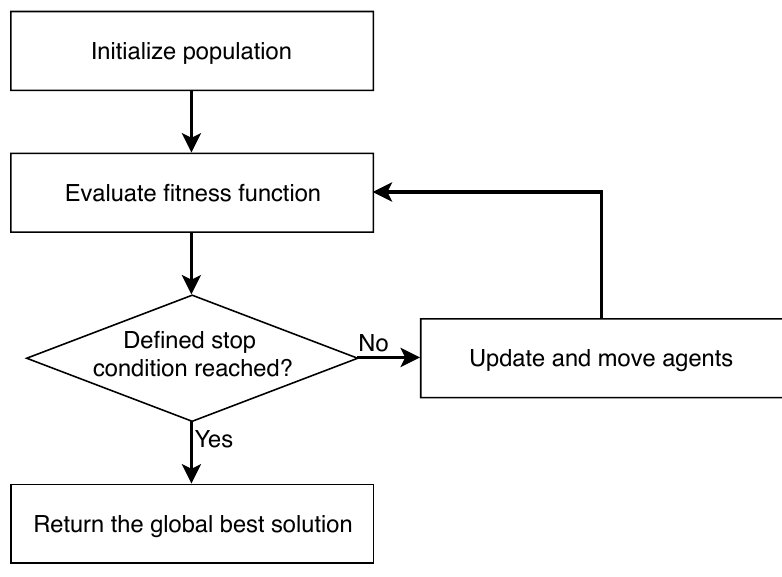
Figure 1. Swarm intelligence